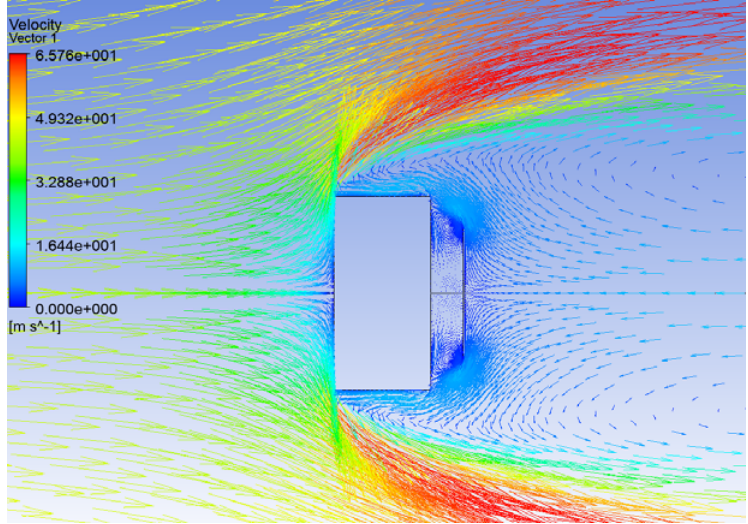
Figure 2. Velocity vectors close to the blocking / sensitive